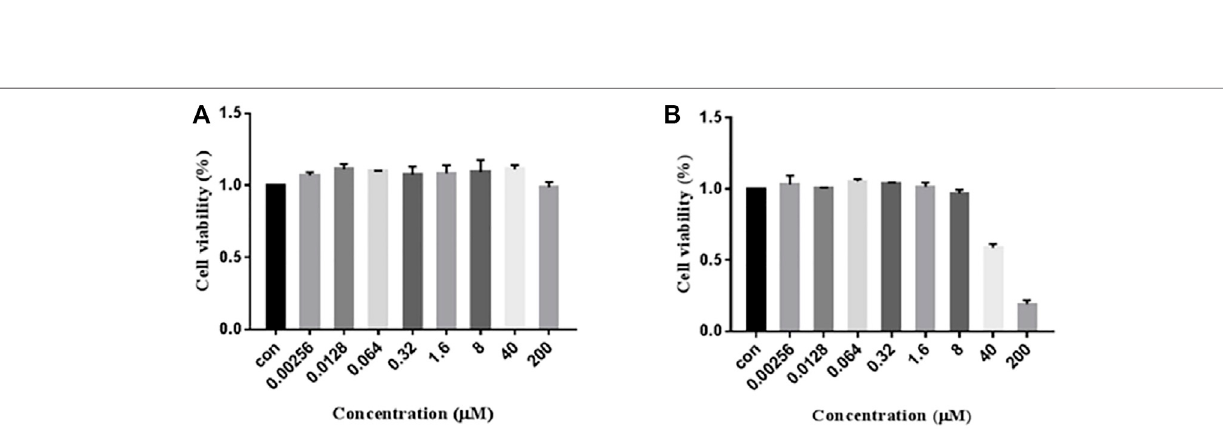
FIGURE6| Cytotoxicityof7979989andZ112553128onRAW264.7Cells.RAW264.7cellsweretreatedwith7979989andZ112553128for24 h,andcellviability was determined by the MTT assay. Each bar represents the mean ± standard deviation (SD) calculated from three independent experiments.